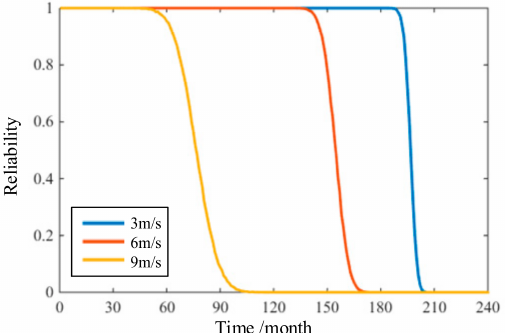
Figure 4. Time-variant reliability curves at different seawater